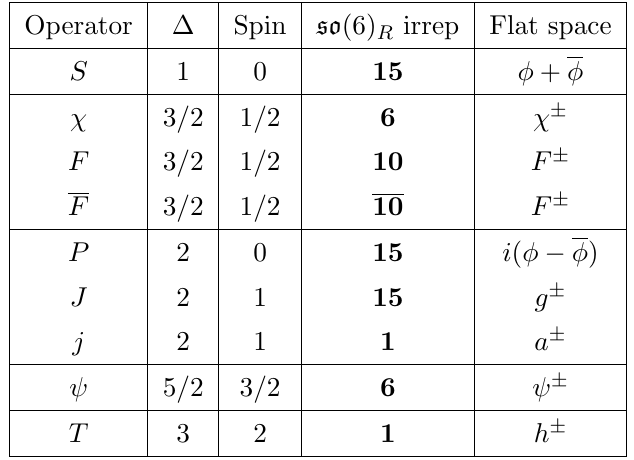
Table 4 . The conformal primary operators in the N = 6 stress tensor multiplet. For each such op- erator, we list the scaling dimension, spin, so (6) R representation, and the particle whose scattering amplitudes it is related to in the (cid:13)at space limit of the AdS 4